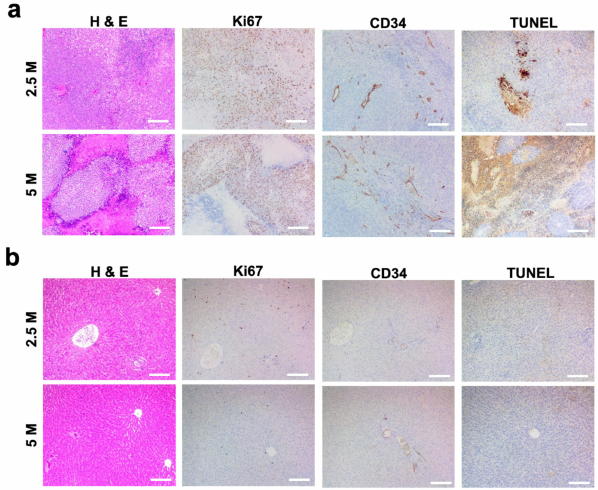
Figure 2. Histological analysis of HCC tumor generated with a subcapsular N1-S1 cells (2.5 and 5 million N1-S1 cells) implantation in Sprague Dawley rats. H&E histology and immunohistology (Ki67, CD34, and TUNEL) images of ( a ) tumor and ( b ) peripheral hepatic region. Scale bars are 150 µ